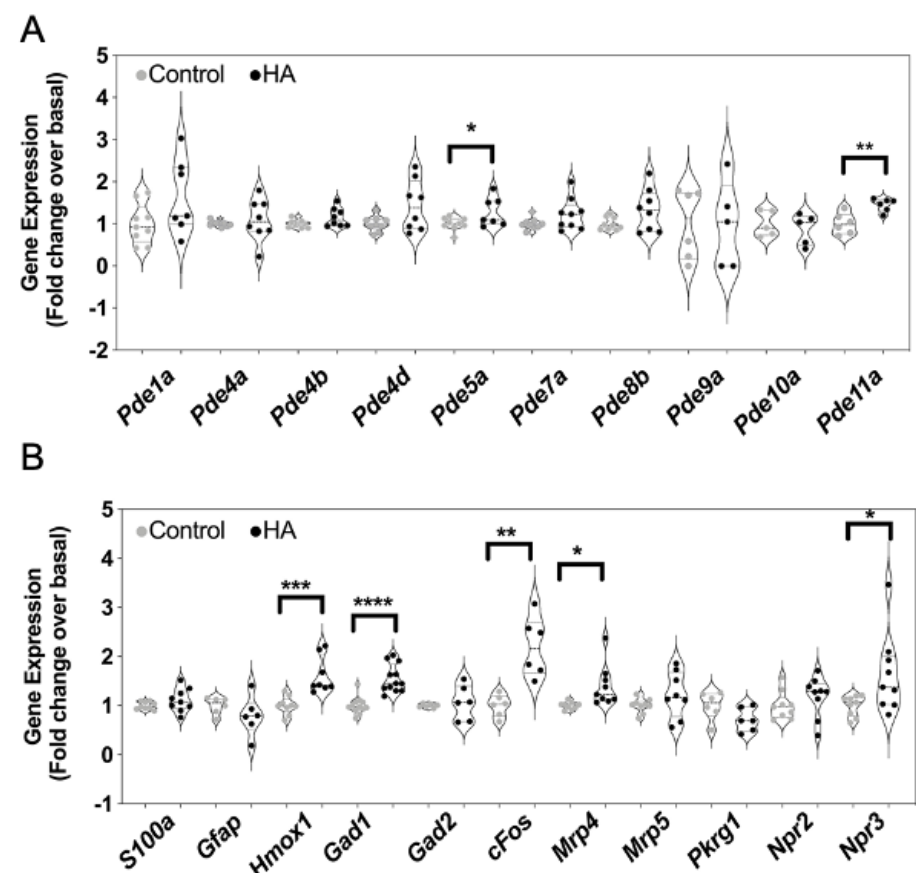
Figure 6. Effects of hyperammonaemia on cGMP-associated, and astrocyte-enriched gene expression in rat C6 glioma cells. Cells were initially treated in media containing 1% ( v / v ) FCS and 0 or 10 mM NH 4 Cl (HA) for 48 h, prior to extracting total RNA. Multiplex RT-qPCR assays were performed on RNA extracted from C6 cells to detect ( A ) transcripts encoding phosphodiesterase enzymes, ( B ) other cGMP-associated genes and astrocyte-enriched transcripts. The data shown are the medians (with 5 to 95% confidence intervals) of relative gene expression, normalized to Actb and expressed as fold change over basal, from 4 to 12 individual RNA extractions. * p < 0.05, ** p < 0.01, *** p < 0.001, **** p < 0.0001, significantly different from